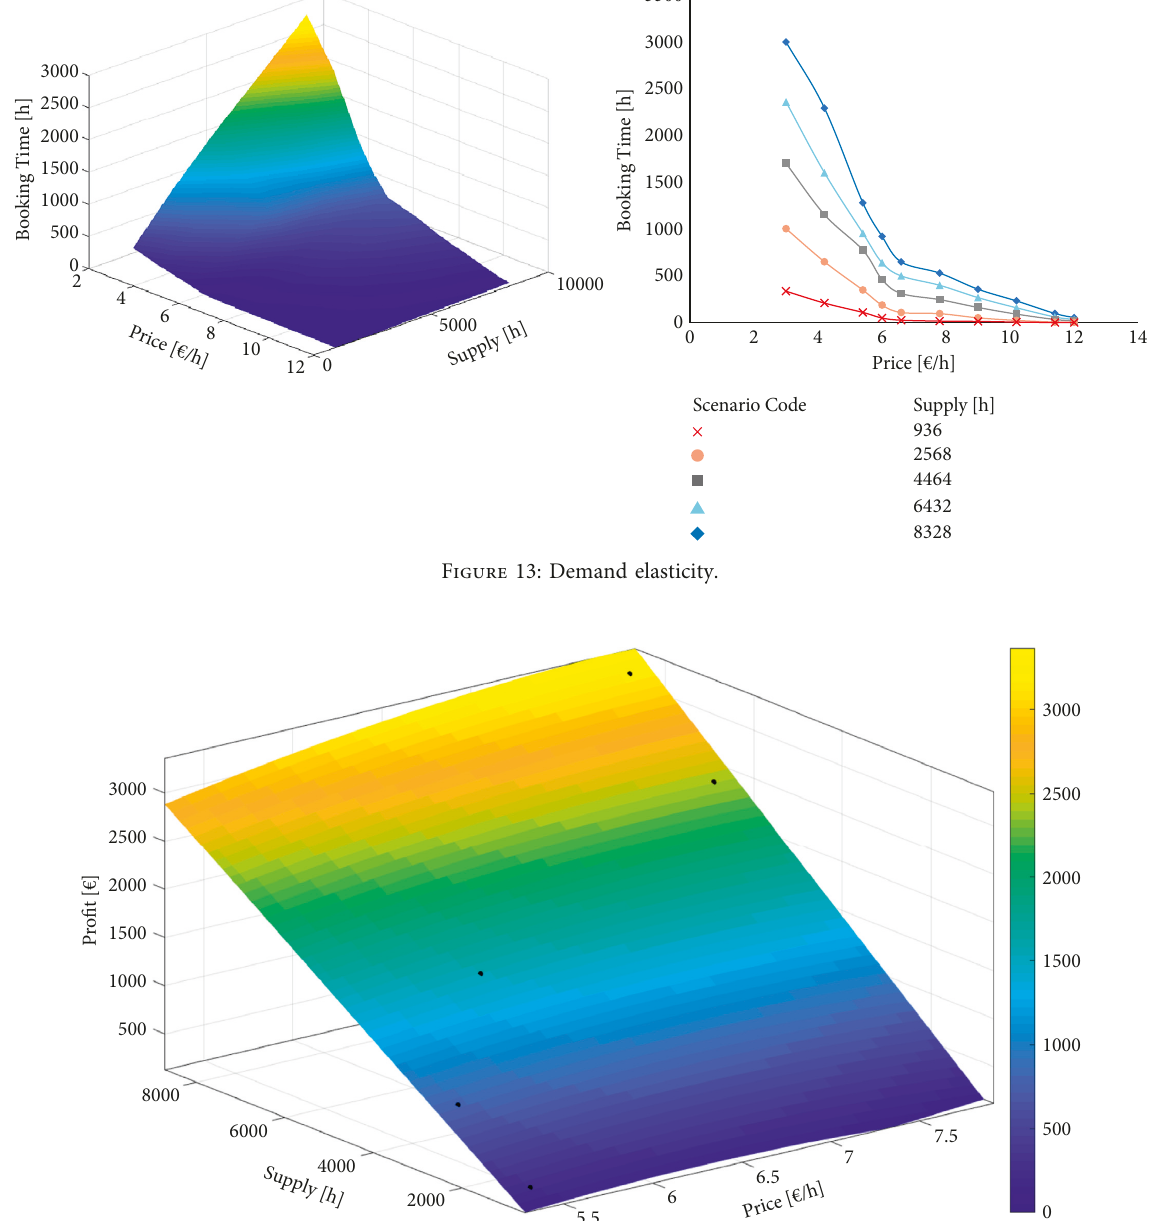
Figure 14: Three-dimensional plane of